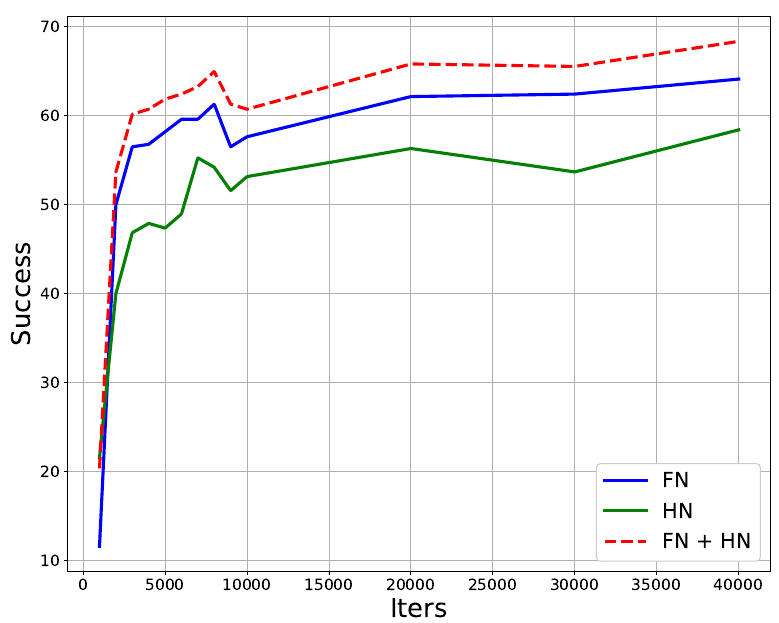
Figure 12. Success of the FN/HN/FN+HN models against the test